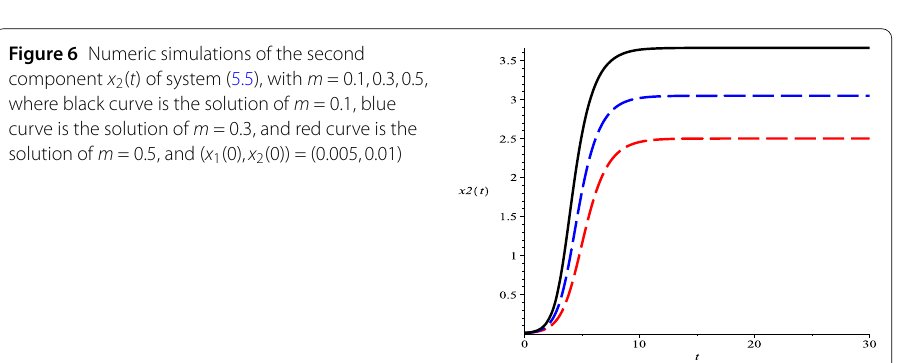
here we choose α = 10, β = δ 1 = δ 2 = E = q 1 = q 2 = 1, γ = 1. In this case,